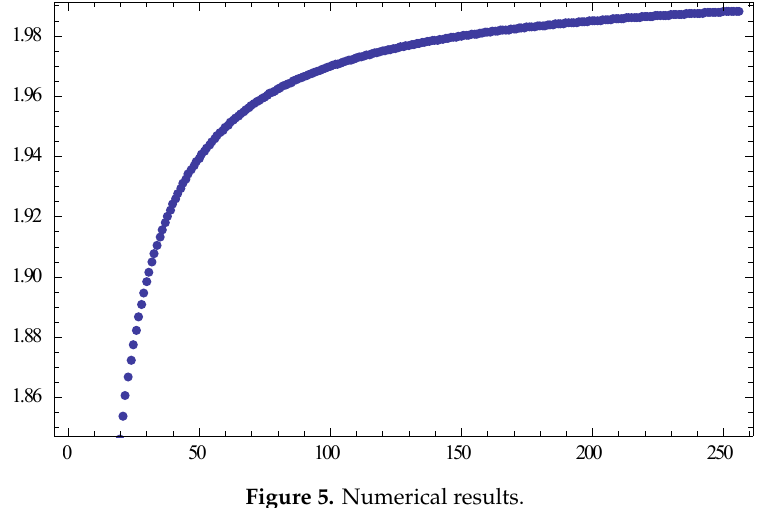
Figure 5. Numerical results.